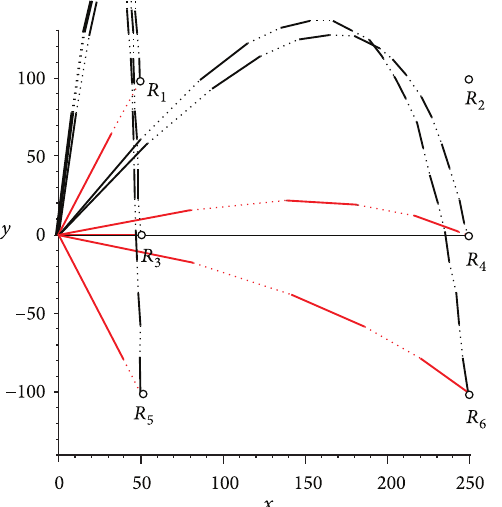
Figure 14: Planning trajectories through six different 𝑅 s, all with an arc height of 50.